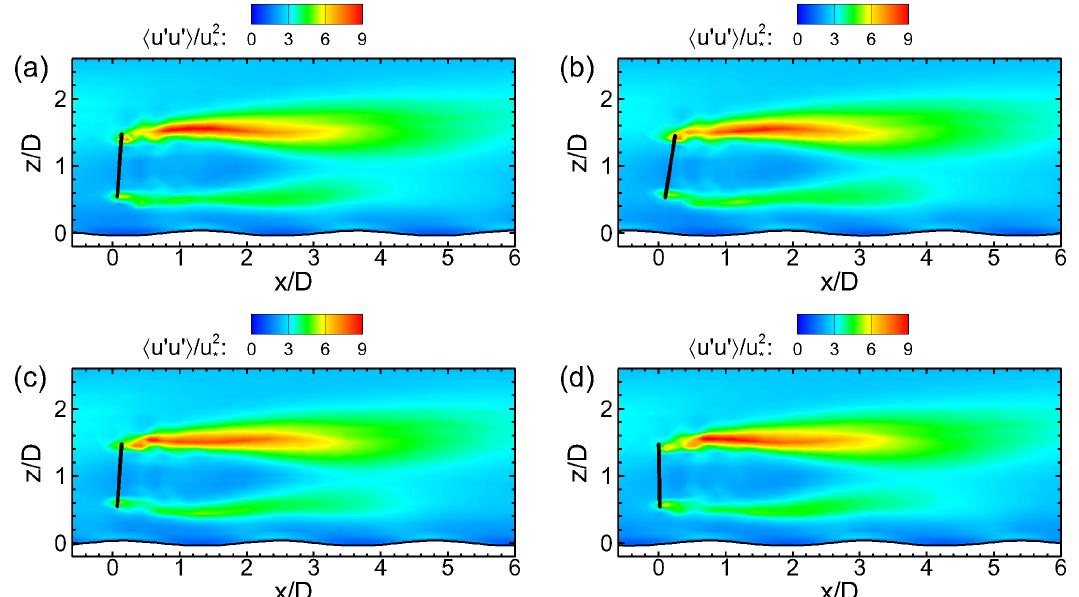
Figure 6. Swell-phase averaged streamwise wind-velocity variance (cid:104) u (cid:48) u (cid:48) (cid:105) at four representative swell phases for pitching-turbine case: ( a ) trough (Phase 1); ( b ) forward slope (Phase 2); ( c ) crest (Phase 3); and ( d ) backward slope (Phase 4). Turbine-rotor-disk location indicated by thick black line.